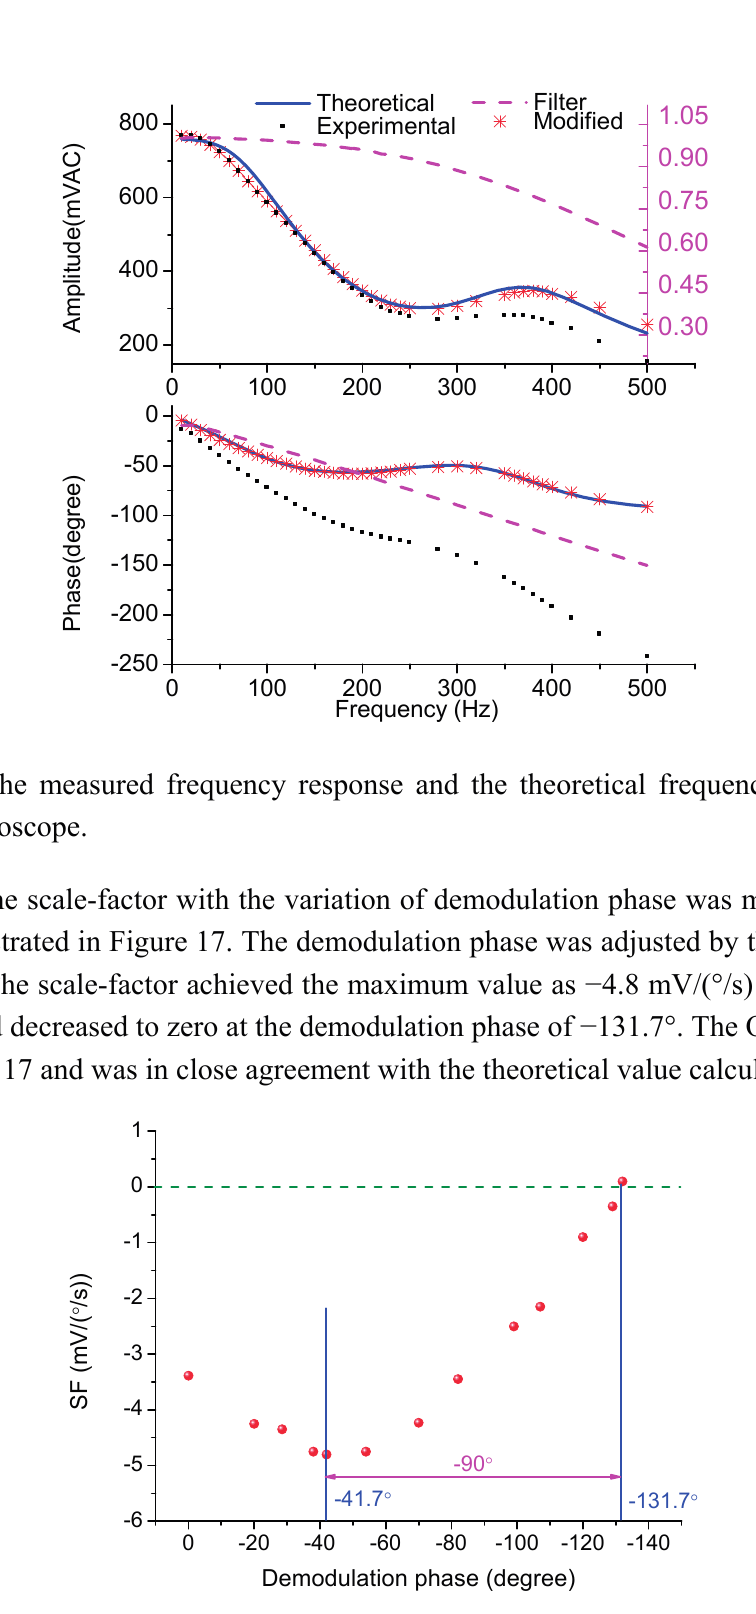
Figure 17. The measured scale-factor with different demodulation